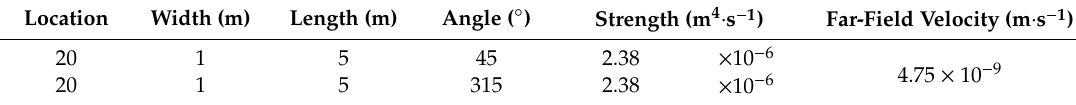
Table A4. Attributes of idealized synthetic flow channels (Case B).